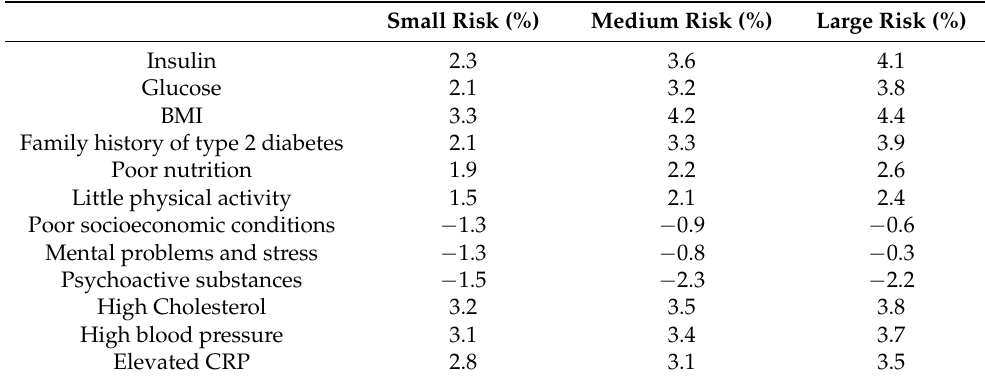
Table 5. Influence risk factors—RBF